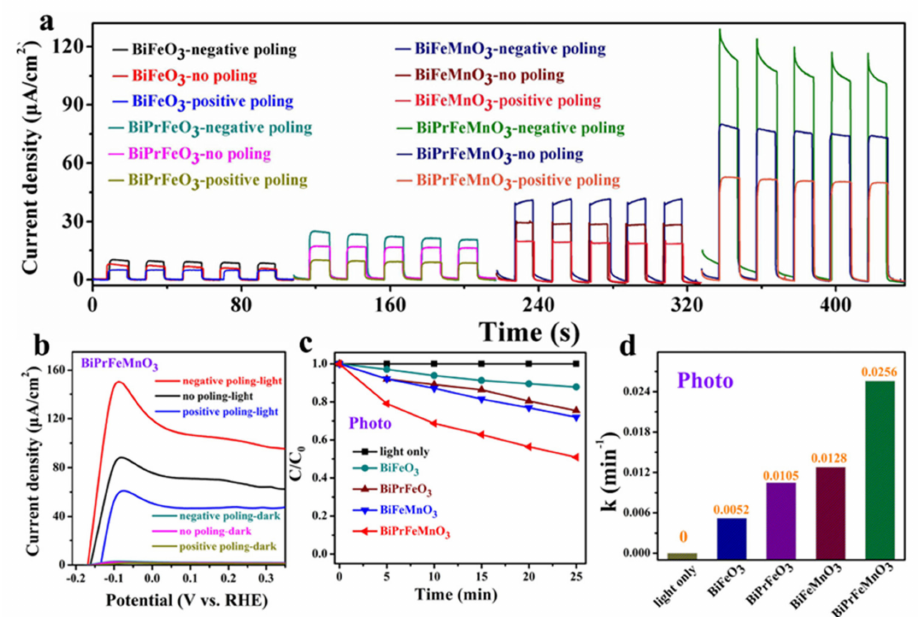
Figure 6. ( a ) Transient photocurrent responses of BiFeO 3 , BiPrFeO 3 , BiFeMnO 3 and BiPrFeMnO 3 photoelectrode with different polarization conditions; ( b ) linear sweep voltammetry curves of BiPrFeMnO 3 photo-anodes with different polarization condition; ( c ) photocatalysis of BiFeO 3 , BiPrFeO 3 , BiFeMnO 3 , BiPrFeMnO 3 nanofibers and control sample (blank test without catalyst) in the reaction of aqueous RhB within 25 min, respectively; ( d ) the corresponding reaction rate constant of photocatalytic activity. Adapted with permission from ref. [76], copyright: 2022,